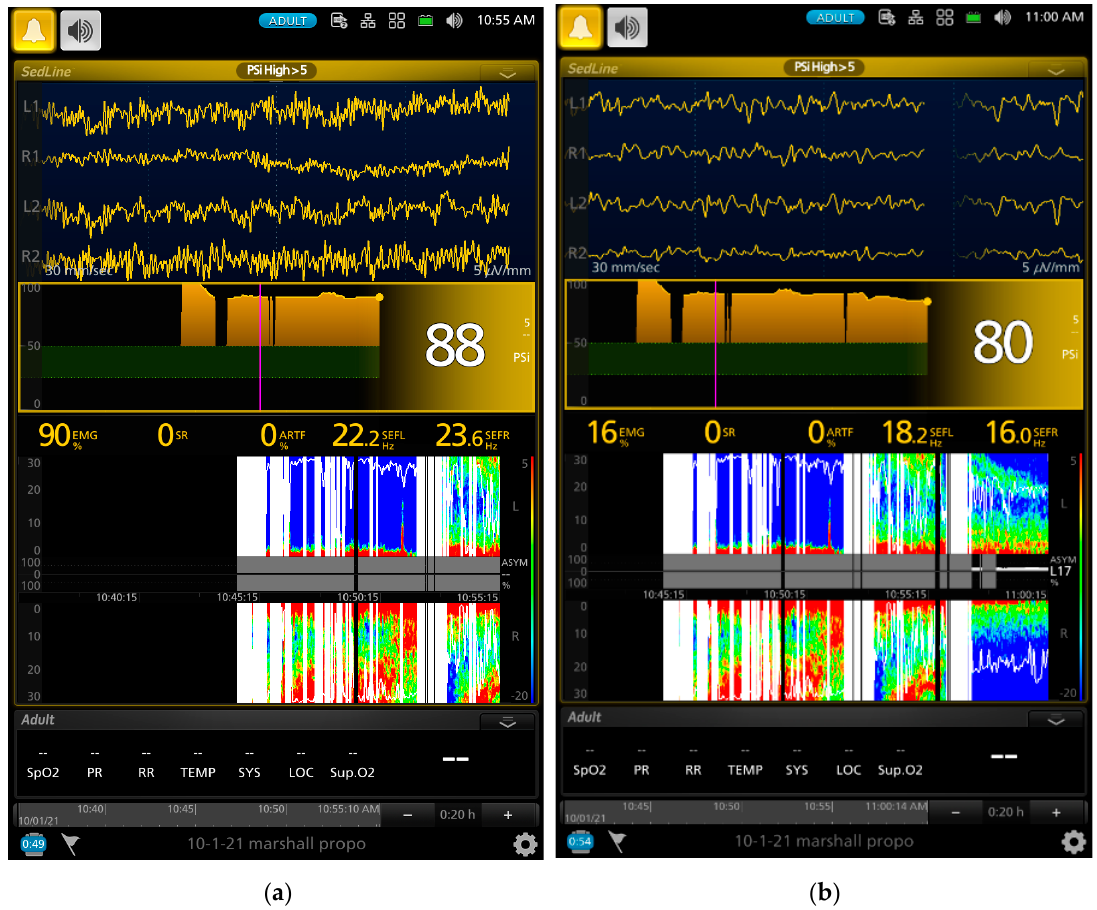
Figure 2. Screenshots of a dog that exhibited paradoxical excitation’s EEG pattern during slow propofol induction. The raw EEG waveforms (the 4 EEG channels in the upper portion of the screen) show regular oscillations of low and high beta waves ( a ). The SEFL 95 (22.2 Hz) and SEFR 95 (23.6 Hz) are outlined as the white horizontal lines in ( a , b ), which indicate 95% of the waves are below these frequency ranges. The intensity of the spectral patterns of the high and low beta waves (18–30 Hz) appeared on the DSA screen while some intensity of the delta and theta waves appeared in bright red on the DSA screen. The high EMG (90% in ( a )) indicates a strong muscle activity that can be observed as high-intensity bright spectral color pattern in the DSA. As the propofol induction continued, the EEG patterns shifted from the regular beta waves to large slow oscillation of alpha, theta, and delta EEG patterns ( b ) with SEFR 95 and SEFL 95 of 16.0 Hz and 18.2 Hz, respectively. The PSI value also decreased from 88 ( a ) to 80 ( b ) and the EMG value decreased from 90% down to 16%. The color map showed a zipper opening pattern with a reduction in the intensity of high beta toward the alpha spectral pattern as a transition into a deeper plane of anesthesia.